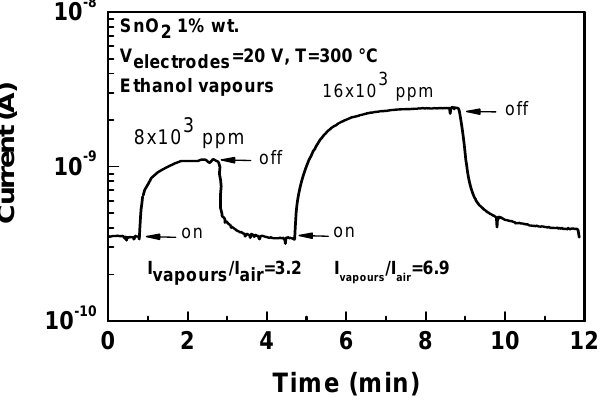
Figure 14 . Typical dynamic response of the MAPLE deposited SnO concentrations of ethanol vapors of 8 and 16x10 3 ppm at the working temperature of 300 °C.